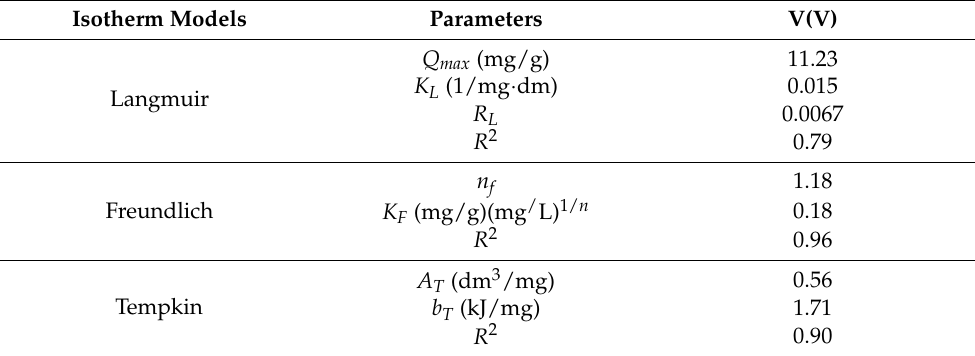
Figure 8. Adsorption isotherm of V(V) sorption onto m-Si-poly(GME)-deta ( T = 298 K, t = 60 min, P = atm) ( a ), Langmuir ( b ), Freundlich ( c ) and Tempkin ( d ) isotherms. Isotherm parameters and regression data are presented in Table 3. Table 3. Isotherm parameters and regression data for V(V) sorption on m-Si-poly(GME)-deta at 298